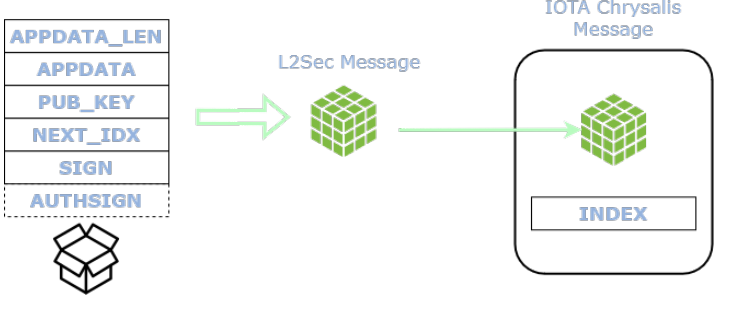
Figure 2. Structure of fields composing an L2Sec message ( left ) and IOTA Chrysalis message ( right